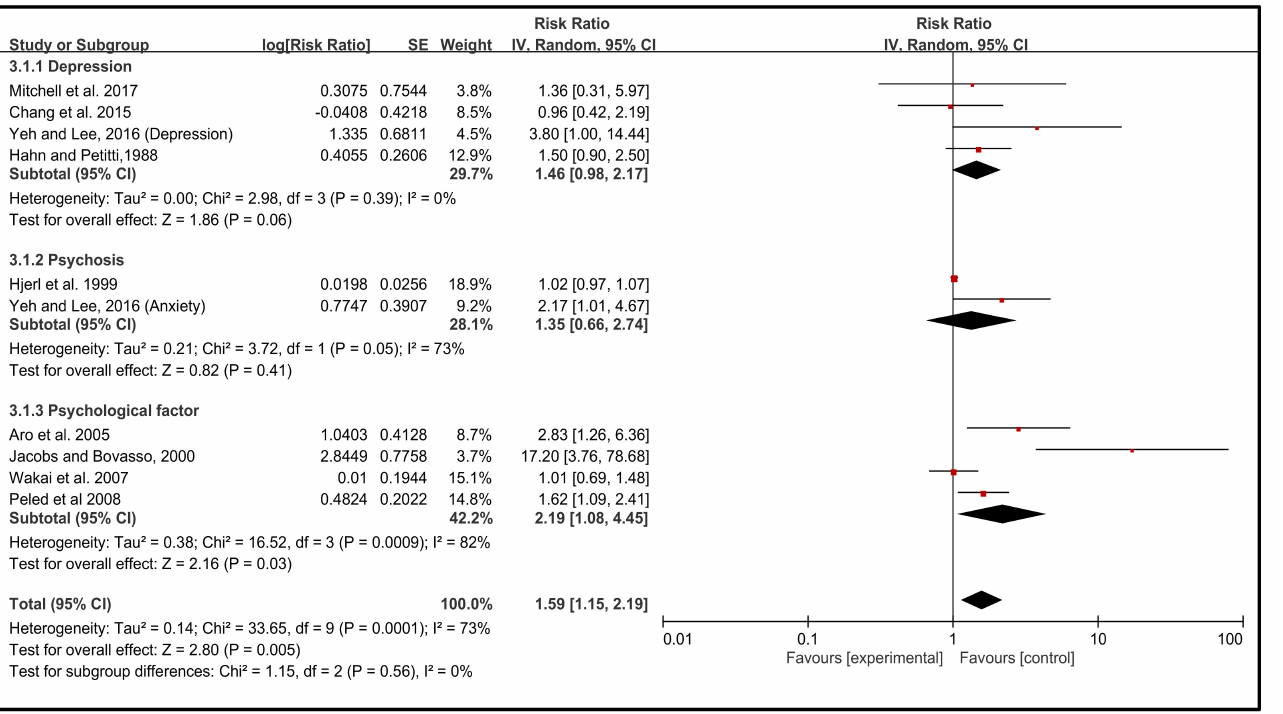
Figure 3. Emotion type. The results were stratified by different emotion types – depression, psychosis, and psychological factors